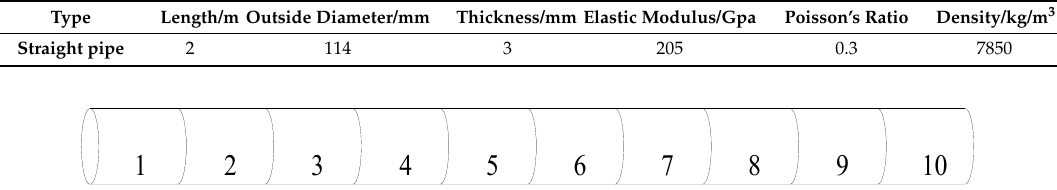
Table 1. Pipe parameters.